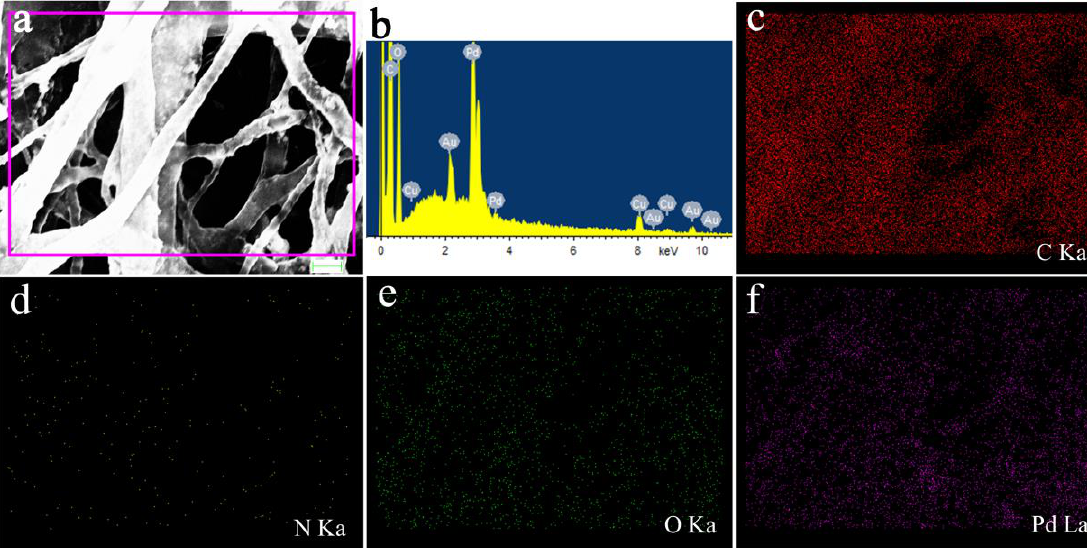
Figure 4. Scanning electron microscope (SEM) and EDS images of as-prepared PEI / PCL@PdNPs composite ( a , b ) and C / O / N / Pd elemental mapping ( c – f ). The scale bar in iamge a represent 1 µm.